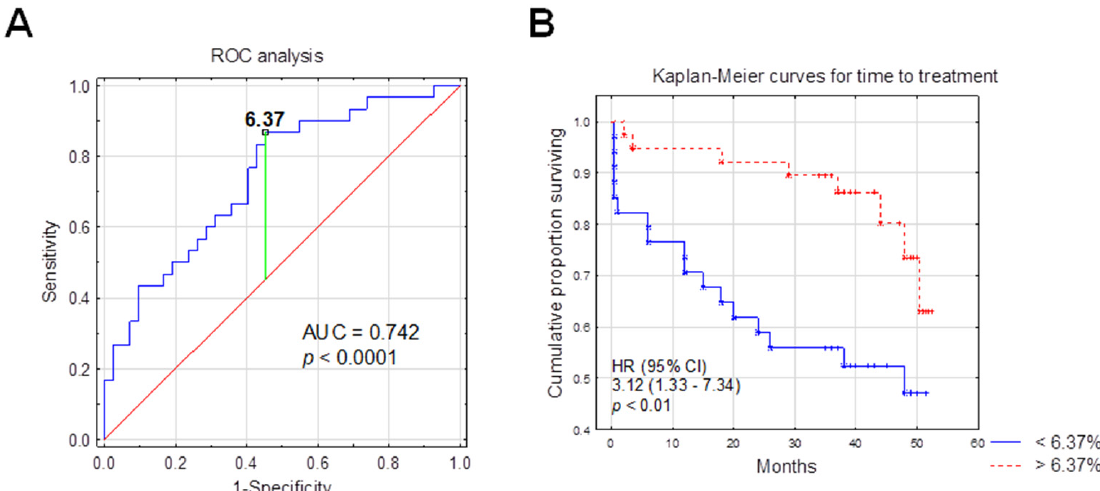
Figure 7. Low CD14 dim CD16 + SLAN + percentage as a negative prognostic marker for the time-to- treatment ( A ) Graph of the ROC curve for the percentage of non-classical monocytes (CD14 dim CD16 + SLAN + ) in ZAP-70-positive patients versus ZAP-70-negative CLL patients. ROC, receiver operating characteristic; AUC, area under the curve. ROC and AUC were used to calculate the most significant cut-off value of the non-classical monocytes (CD14 dim CD16 + SLAN + ) percentage that best distinguished ZAP-70-positive and ZAP-70-negative CLL cases. ( B ) Kaplan–Meier curve comparing time-to-treatment-initiation (TTT) in groups of CLL patients with the percentage of non- classical CD14 dim CD16 + SLAN + monocytes ( ≤ 6.37% and >6.37%). The division of CLL patients into two groups was made with reference to the cut-off point determined using the ROC curve analysis. HR, hazard ratio; CI, confidence interval.